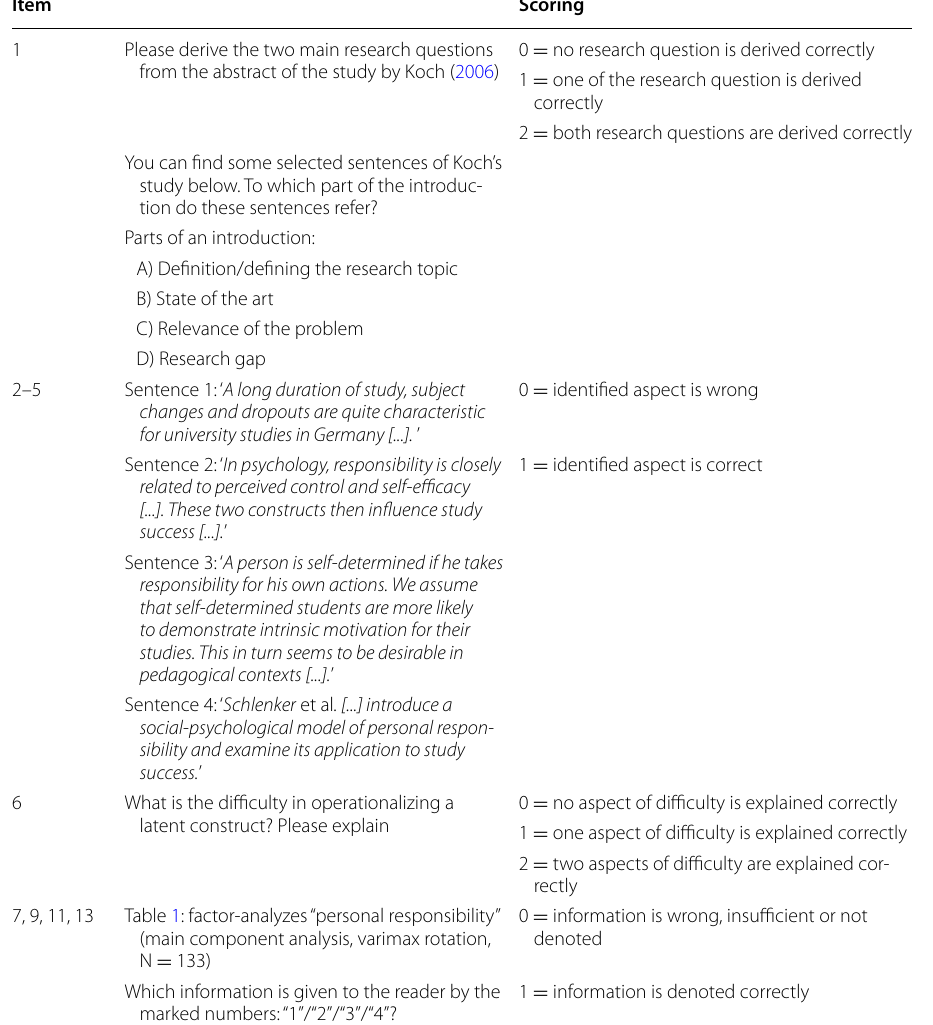
Table 5 Instruction and scoring rules of the CCER test items Item Scoring